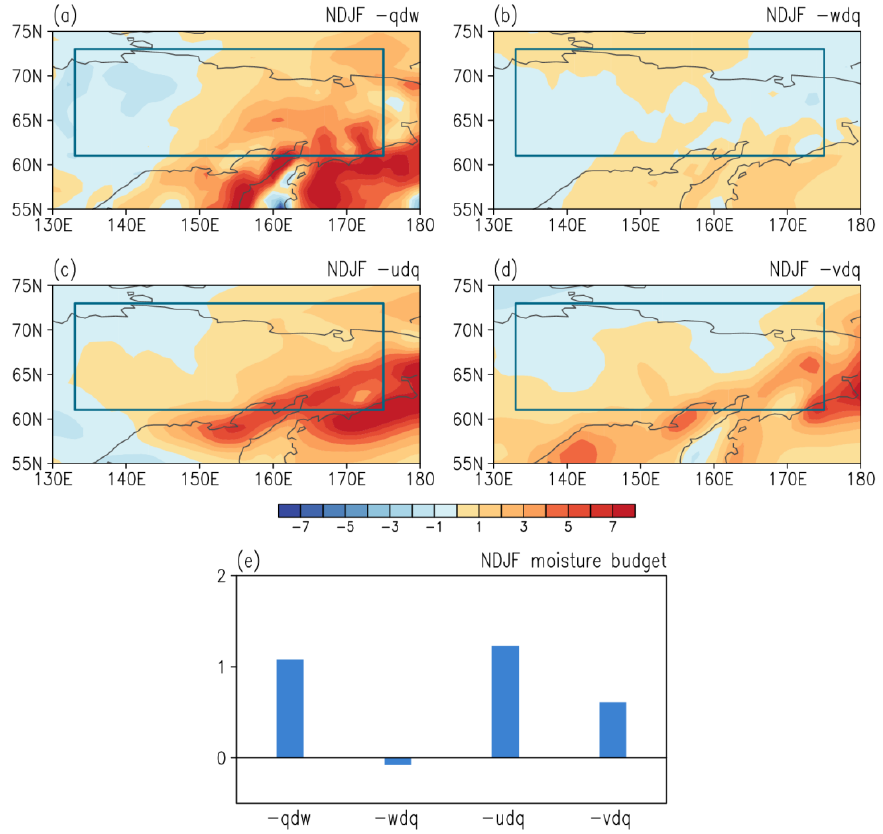
Figure 7. The moisture budget terms in NDJF of ( a ) dynamic effect (-qdw, mm month −1 10a −1 ), ( b ) thermodynamic effect (-wdq, mm month −1 10a −1 ), ( c ) zonal moisture horizontal advection (-udq, mm month −1 10a −1 ), and ( d ) meridional moisture horizontal advection (-vdq, mm month −1 10a −1 ). ( e ) Anomalies of moisture budget terms in NDJF of -qdw, -wdq, -udq, and -vdq averaged over east Siberia for the period 2000 – 2019.